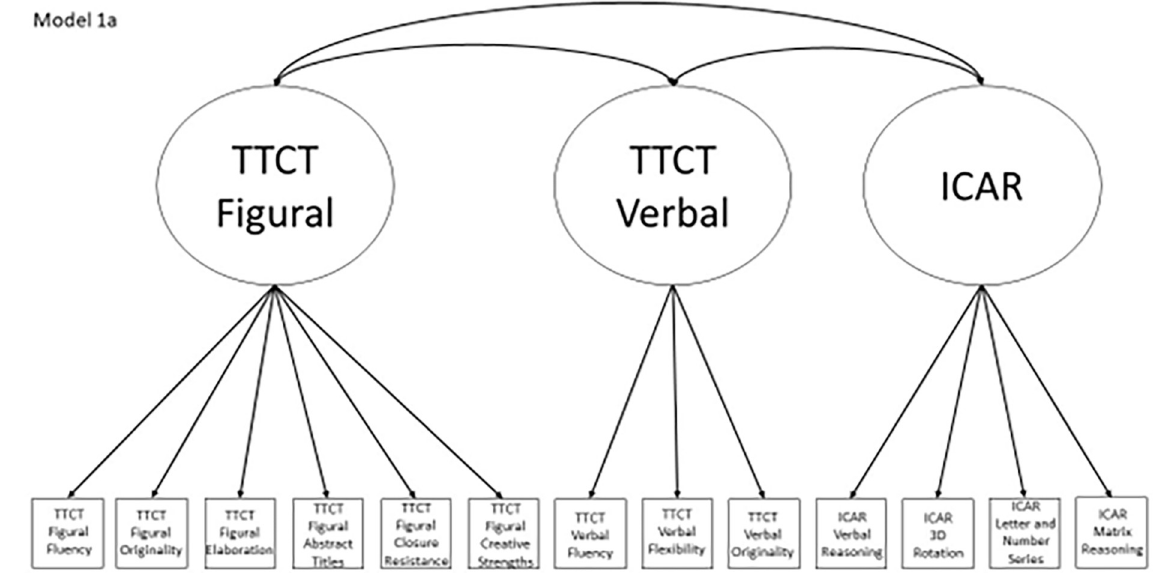
Fig 2. Confirmatory factor analysis diagram for model 1a.